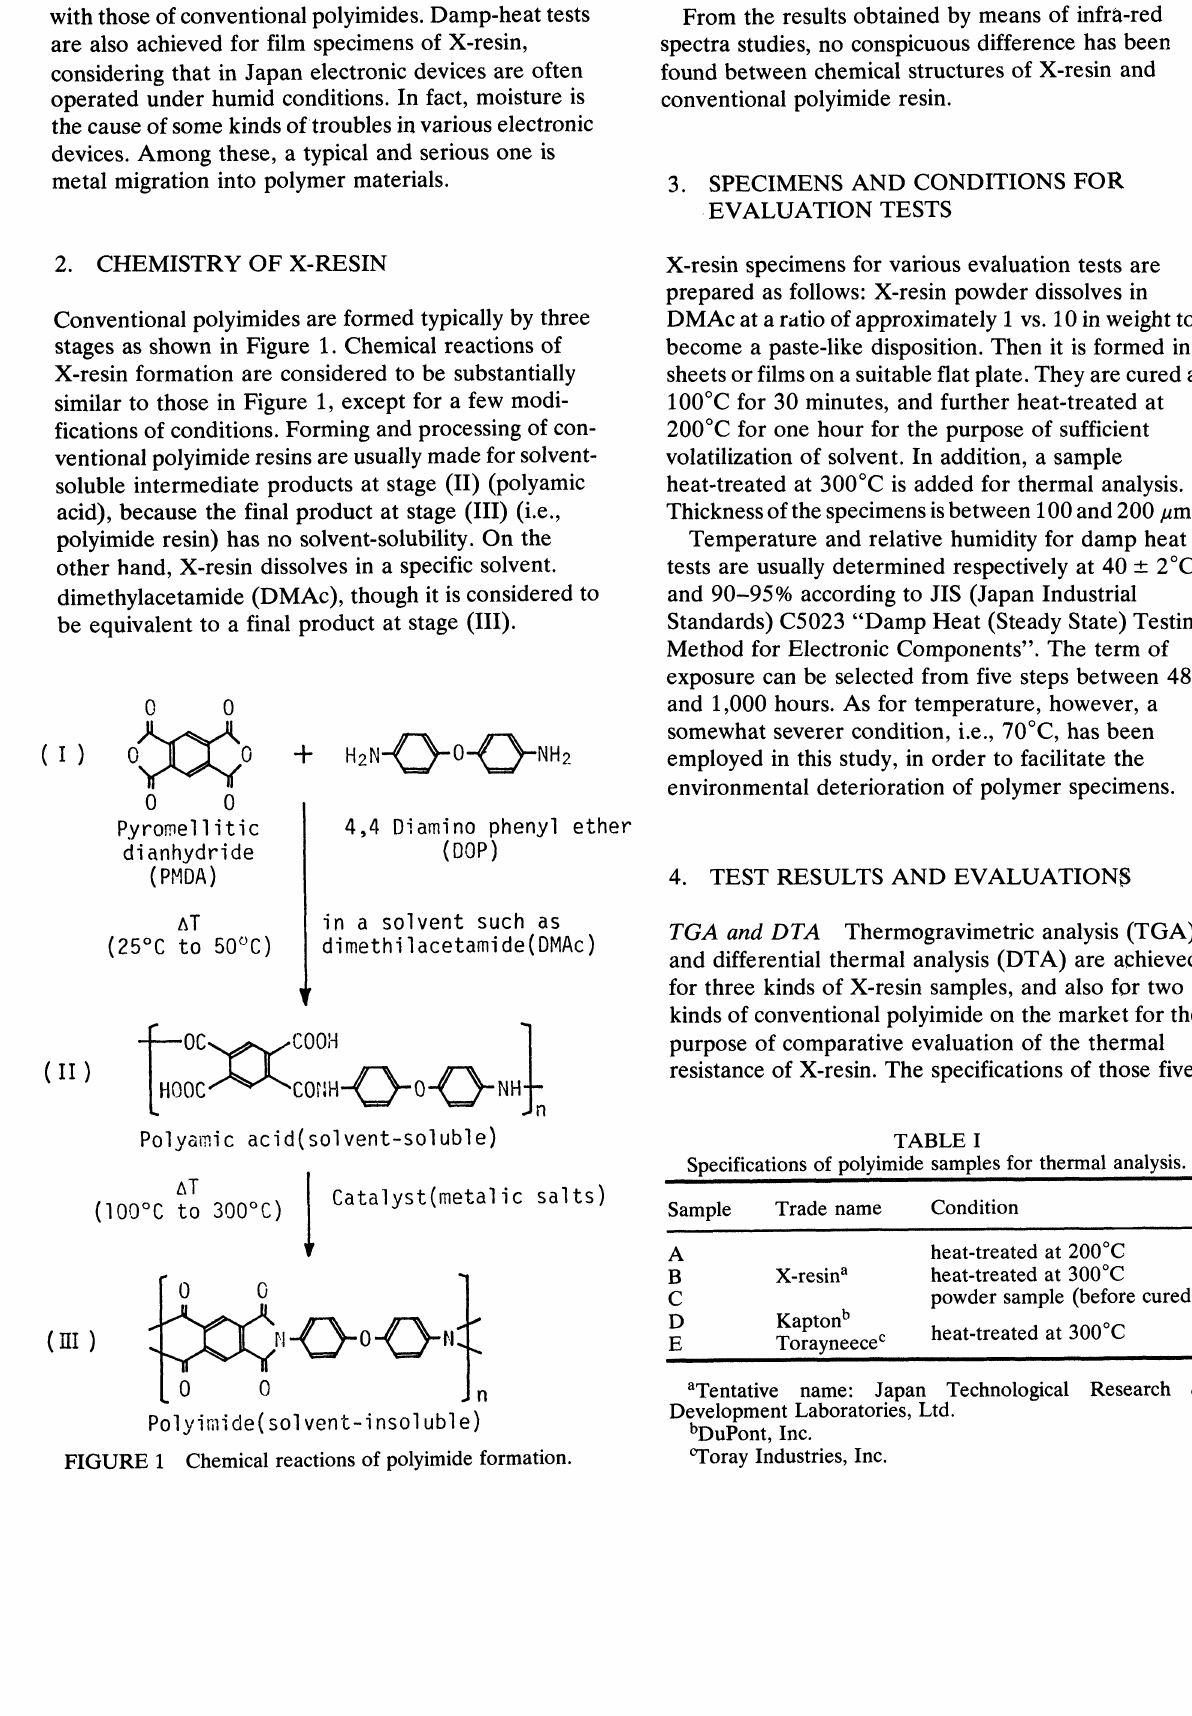
Specifications of polyimide samples for thermal